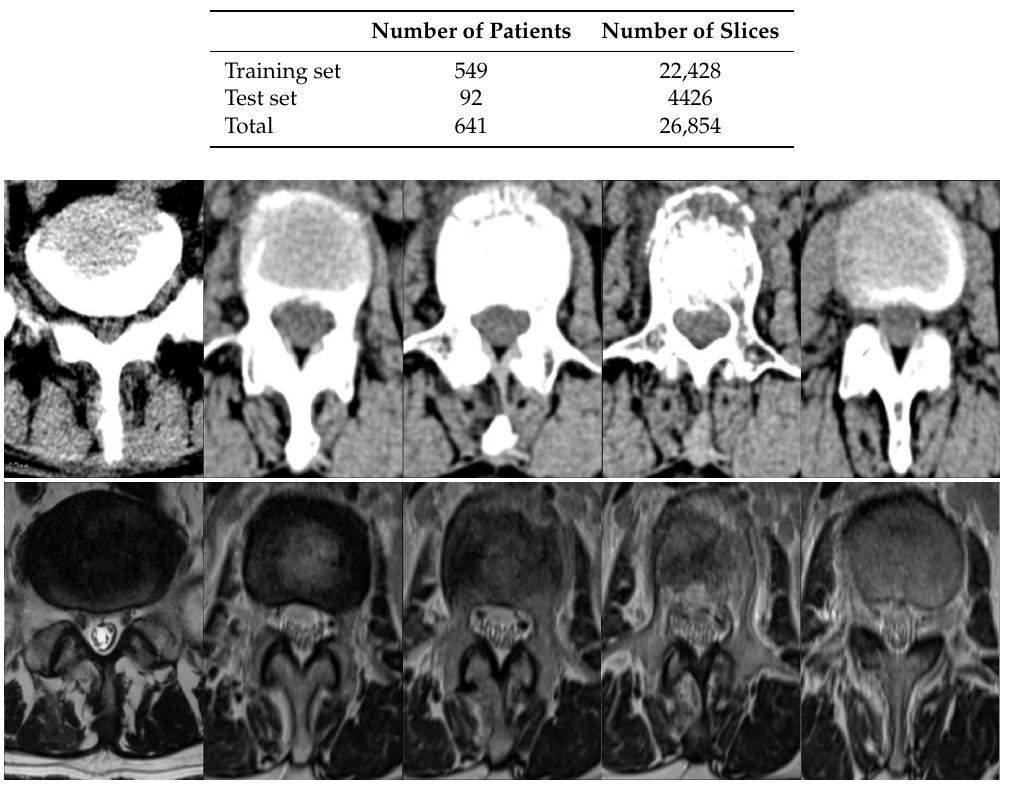
Table 5. Summary of the lumbar vertebra dataset used in the experiments.